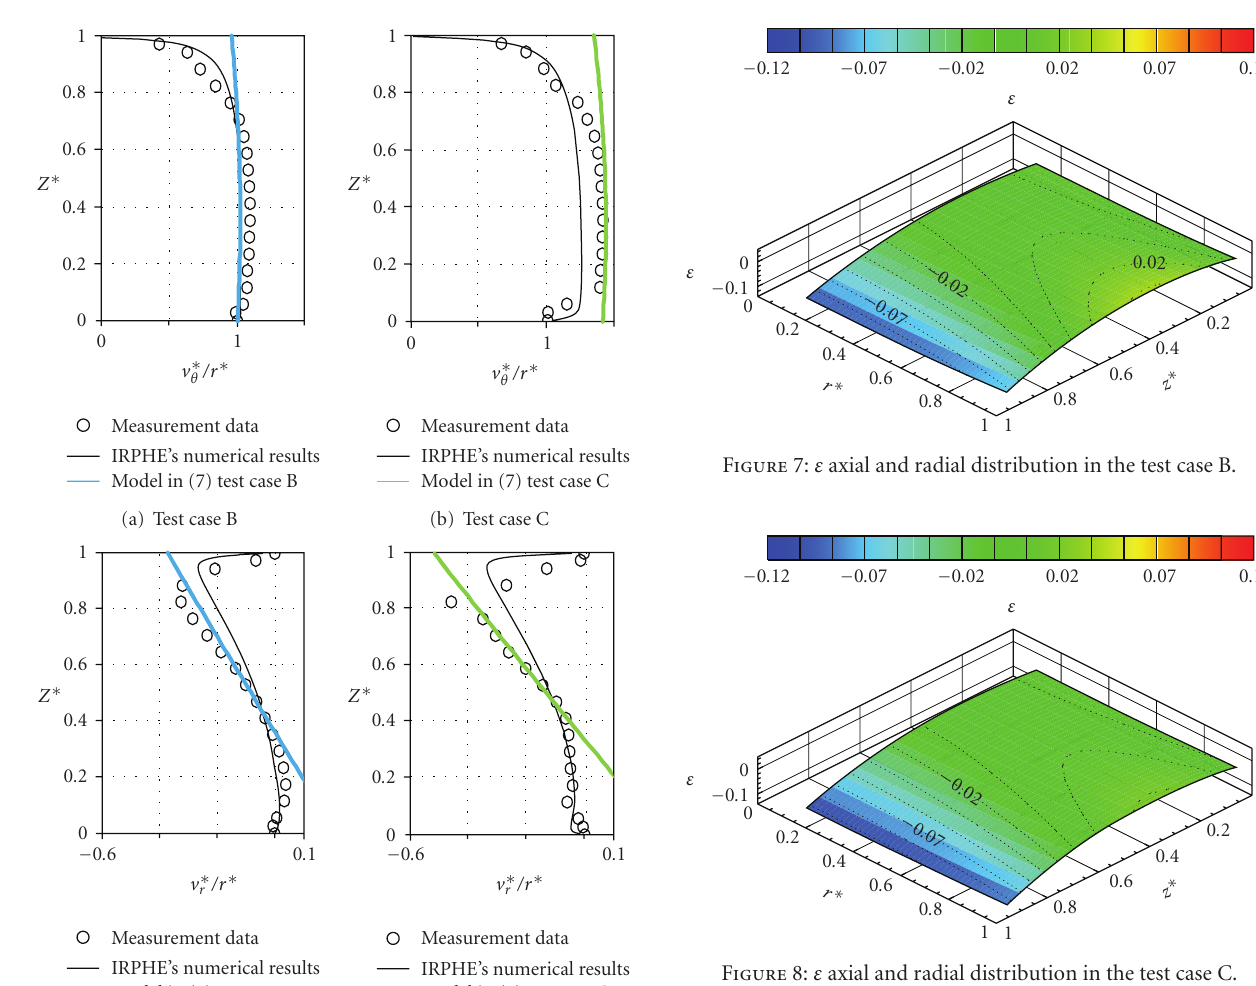
Figure 8: ε axial and radial distribution in the test case C.